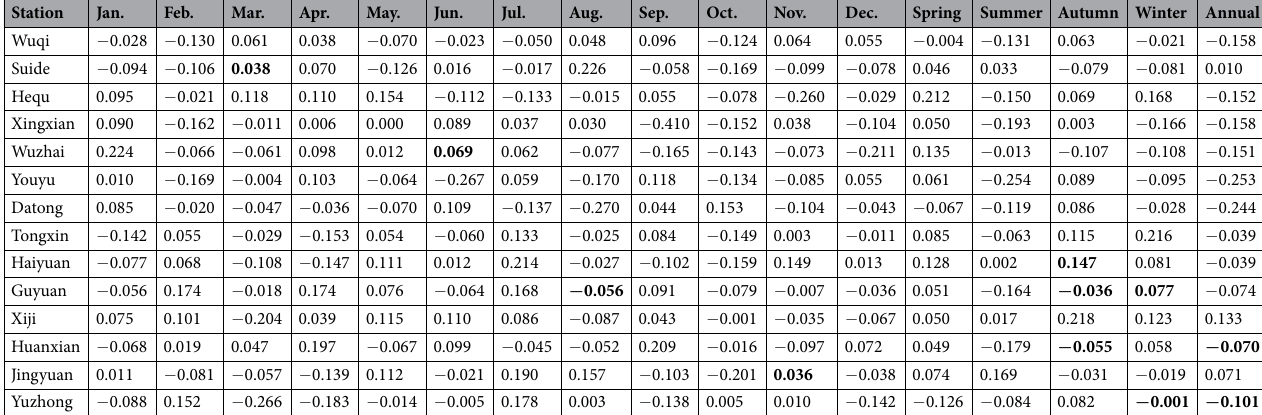
Table 2. Lag-1 serial autocorrelation coefficient of precipitation at different time scales. Bold indicates that autocorrelations in the precipitation time series were